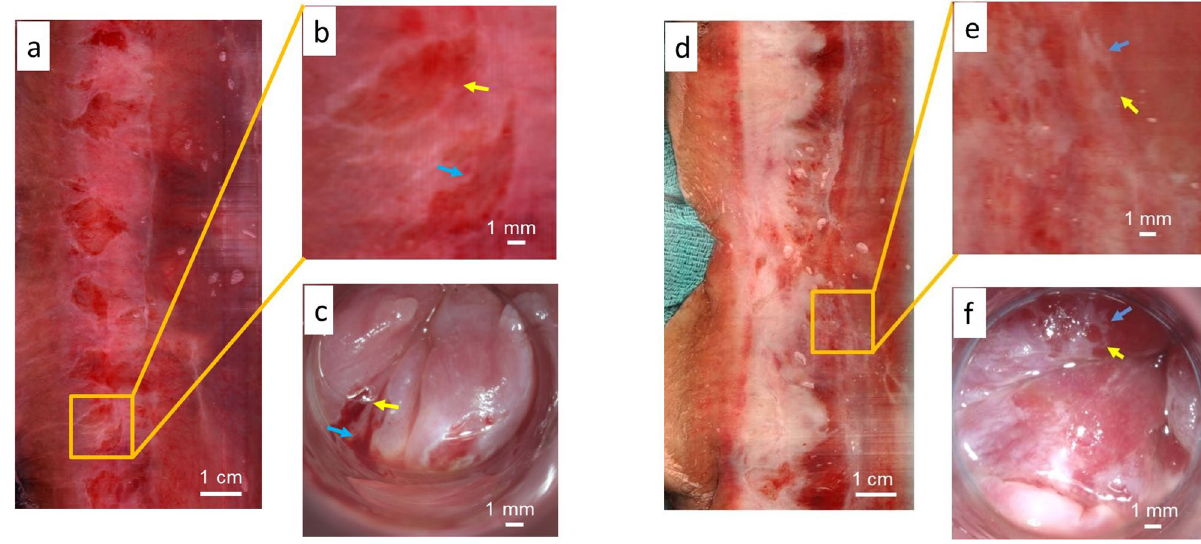
Figure 3. Wide FOV circumferential images are comparable to HRA images of the anal canal. Two examples of anal canal imaging are shown. ( a , d ) The wide FOV circumferential image of the entire anal canal. ( b , e ) A digital zoomed-in image of an area of interest. ( c , f ) The colposcope (HRA) image of the same area shown in ( b ) and ( e ). The colored arrows point to the same areas of interest as imaged using the device and as imaged through HRA.